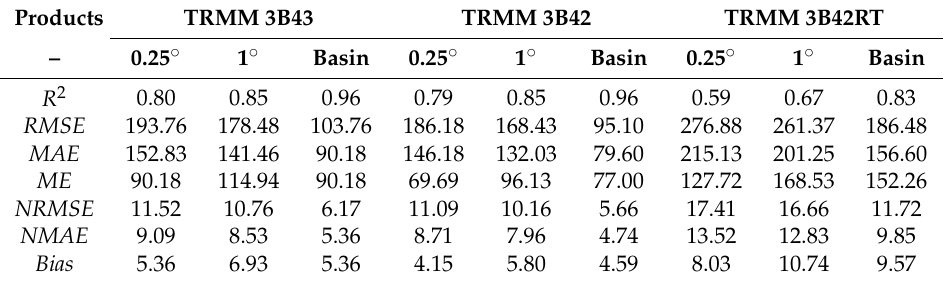
Table 1. Validation statistics comparing satellite rainfall estimates with gauge data at the annual scale.